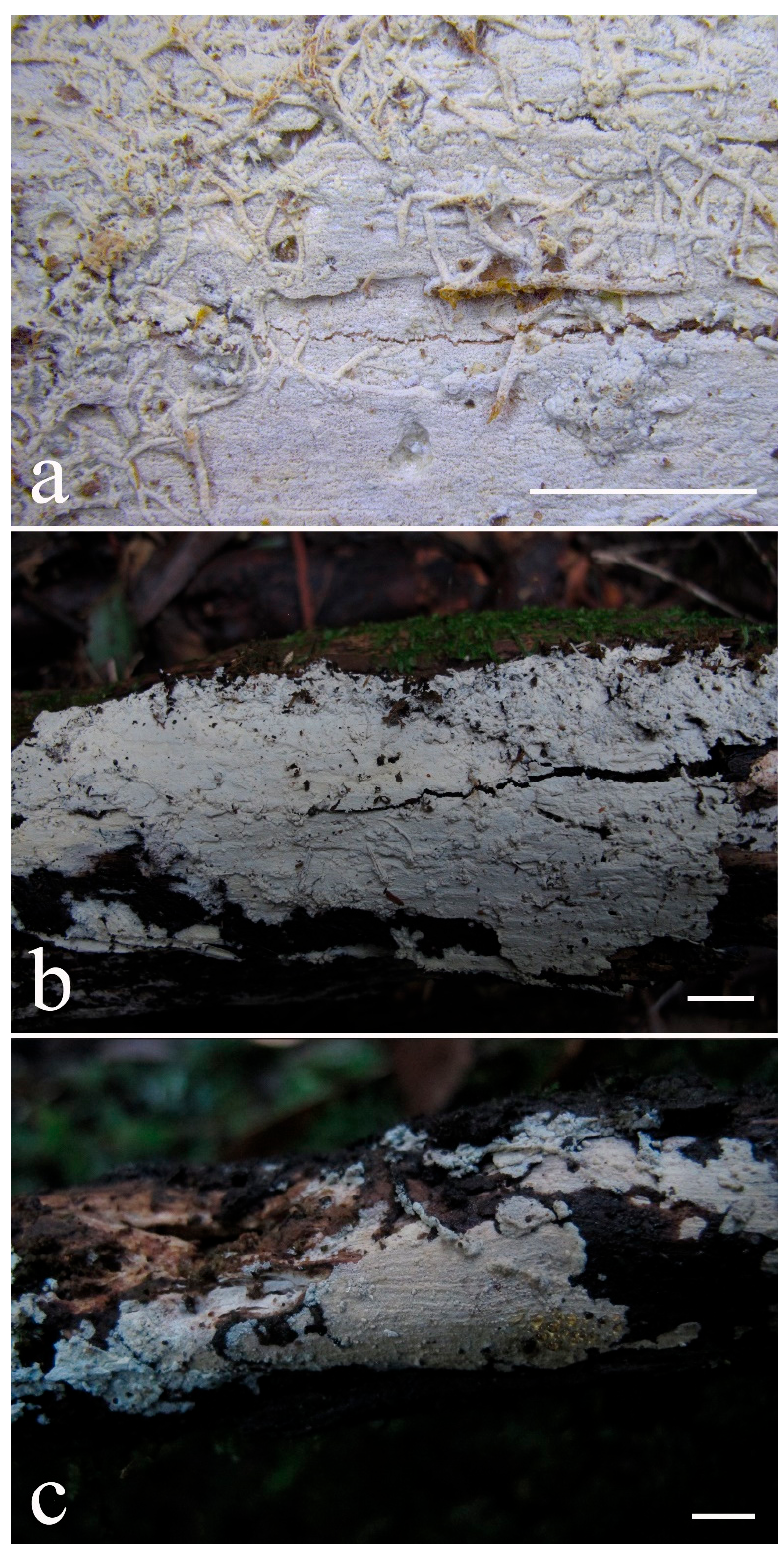
Figure 26. Basidiocarps of Xylodon lagenicystidiatus . ( a ), ( b ) LWZ 20180513-16 (holotype); ( c ) LWZ 20180515-1 (paratype).— Scale bars: a = 5 mm; b = 1 cm; c = 2 cm.